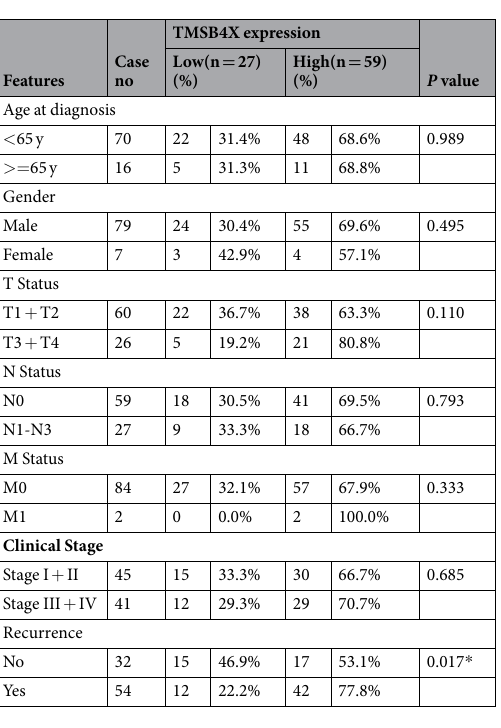
Table 2. The correlation analysis of TMSB4X expression and clinicopathological features in HNSCC cohort.